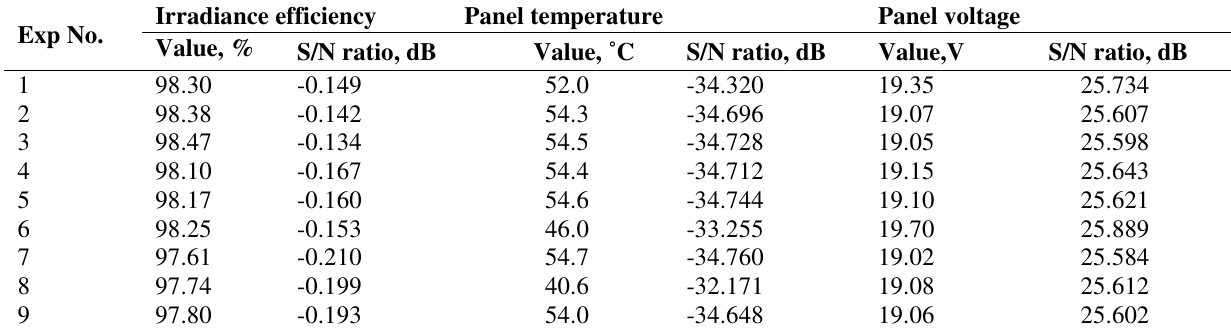
S/N ratio values of the experimental results.